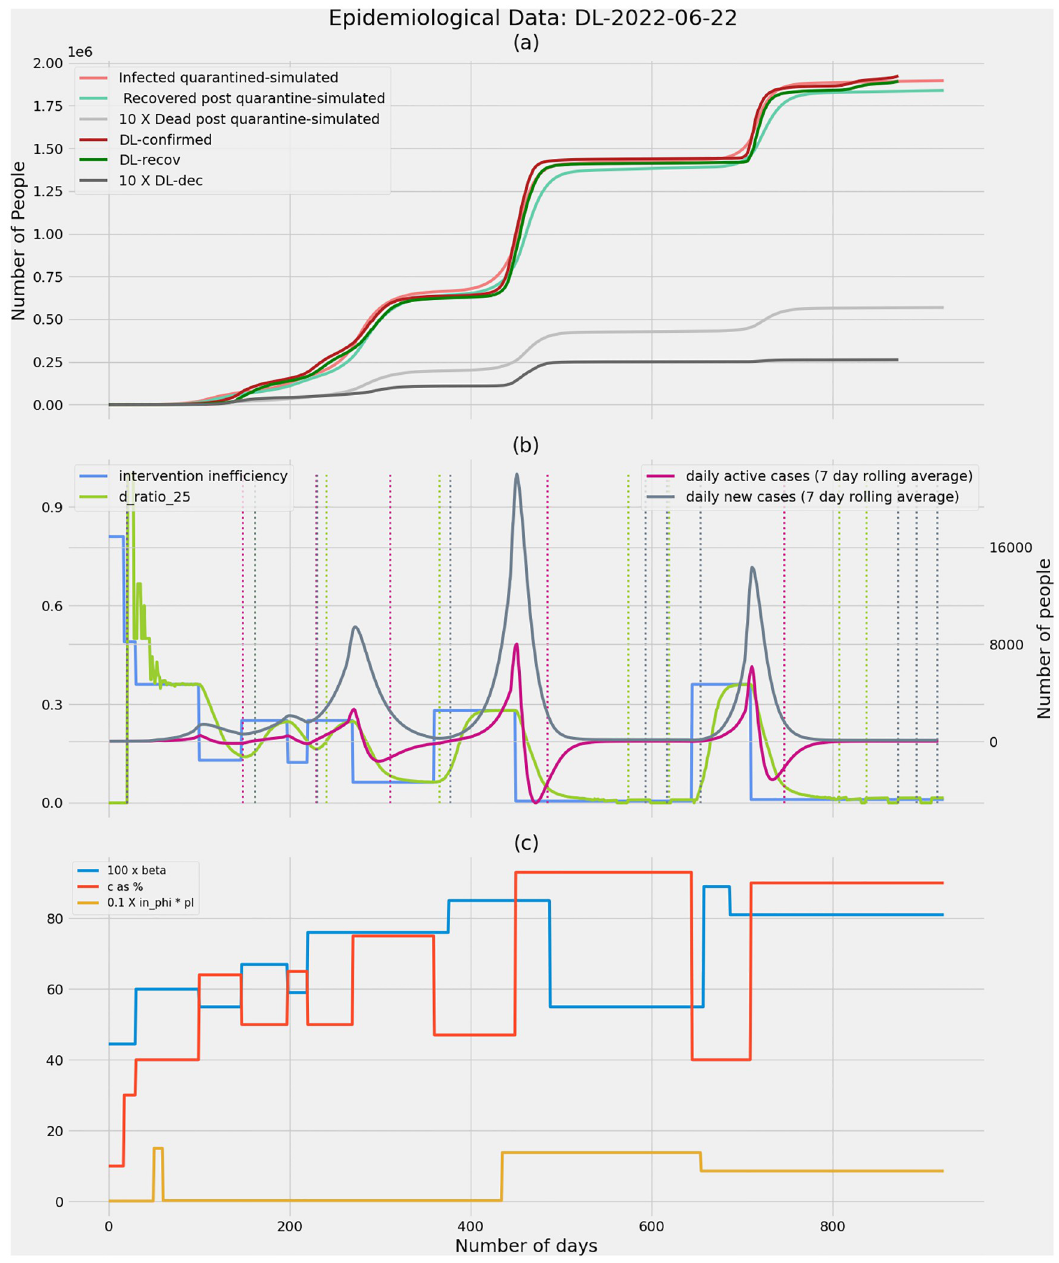
Fig 6. Delhi as on 22nd June 2022. (a) Real COVID-19 data and simulated data showing confirmed cases, recoveries and deaths. It is observed that simulations match the real case growth to a great extent. (b) The intervention inefficiency underlying the epidemic is plotted along with the ratio of deaths from undetected infections to total number of deaths (D ratio ), daily new cases and active cases. The dashed vertical lines correspond to the potential time points when an intervention can be made based on the respectively coloured D ratio , daily active cases and daily new cases. D ratio predicts an upcoming wave ahead of other metrics when the wave is precipitated due to a drop in efficiency (decreasing values of ‘c’—the fraction of infections detected through contact tracing). (c) The model parameters beta, fraction of infections that get detected through contact tracing—’c’, the fraction of infections spread through migrant population—’in phi � pI’ are tuned to fit the model to real